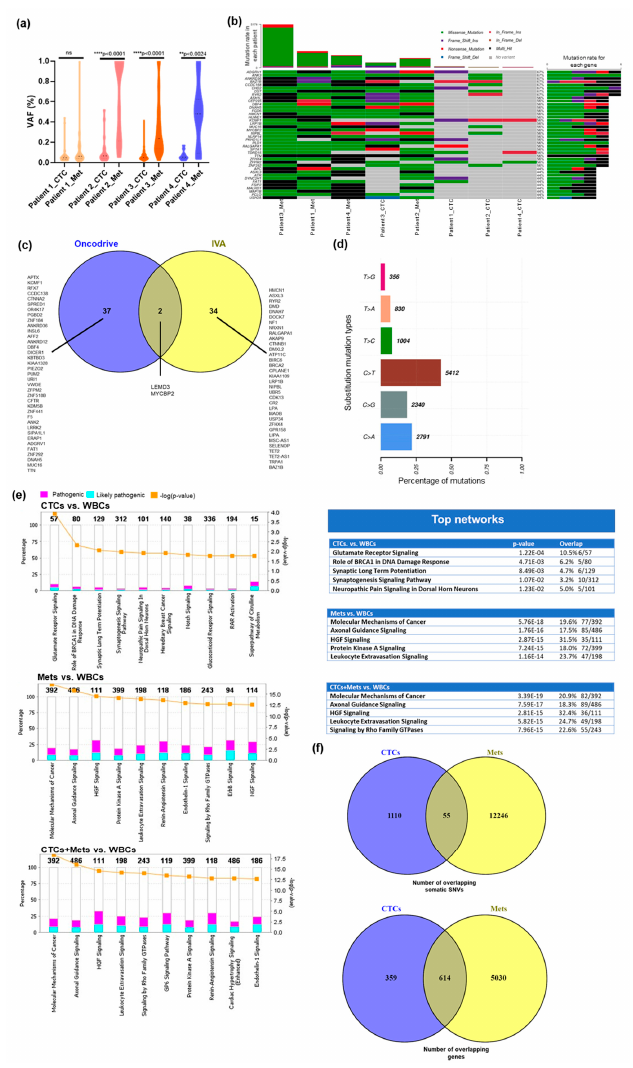
Figure 2. Overview of somatic mutations in circulating tumor cells (CTCs) and matched metastatic tissues ( a ) Violin plot showing the distribution of VAFs across four CTC samples with matched formalin-fixed para ffi n-embedded (FFPE) tissue (two-tailed paired t-test, p < 0.05). The black dots indicate the median and quartile of VAFs and violins extended to represent the entire data range. ( b ) Oncoplot showing the 40 most frequently mutated genes color-coded by type of mutations in CTCs and matched metastatic tissues. The percentage to the right of the oncoplot shows the percent of samples with variants for the corresponding gene. Right, barplot shows the mutation rate in each of the 40 mutated genes; Top, barplot shows the mutation rate for each patient for 40 most frequently mutated genes. By default, samples are ordered by the most frequently mutated genes. ( c ) Overlap of the most frequently mutated genes identified by Maftools and IVA to identify shared cancer drivers in CTCs and metastases. ( d ) Distribution of base substitutions in CTCs and metastases revealing a signature characterized predominantly by C > T followed by C > A substitutions. The percentage of mutations are shown on the x-axis and substitution mutation types are on the y-axis. ( e ) Bar chart showing the enriched canonical pathways in CTCs vs. white blood cells (WBCs), Metastases vs. WBCs, and CTCs + Metastases vs. WBCs. The y-axis on the left shows the percentage of genes overlapping in each pathway having pathogenic (pink) and likely-pathogenic (blue) variants. The y-axis on the right shows the significance level. The number on the top of each stacked bar indicates the total number of genes present in each pathway. The orange line represents the threshold value (0.05) for the significance level for -log( p -value)). The graph is displaying only those entities that have a -log( p -value) greater than 1.3. ( f ) The number of overlapping somatic SNVs and genes in CTCs and